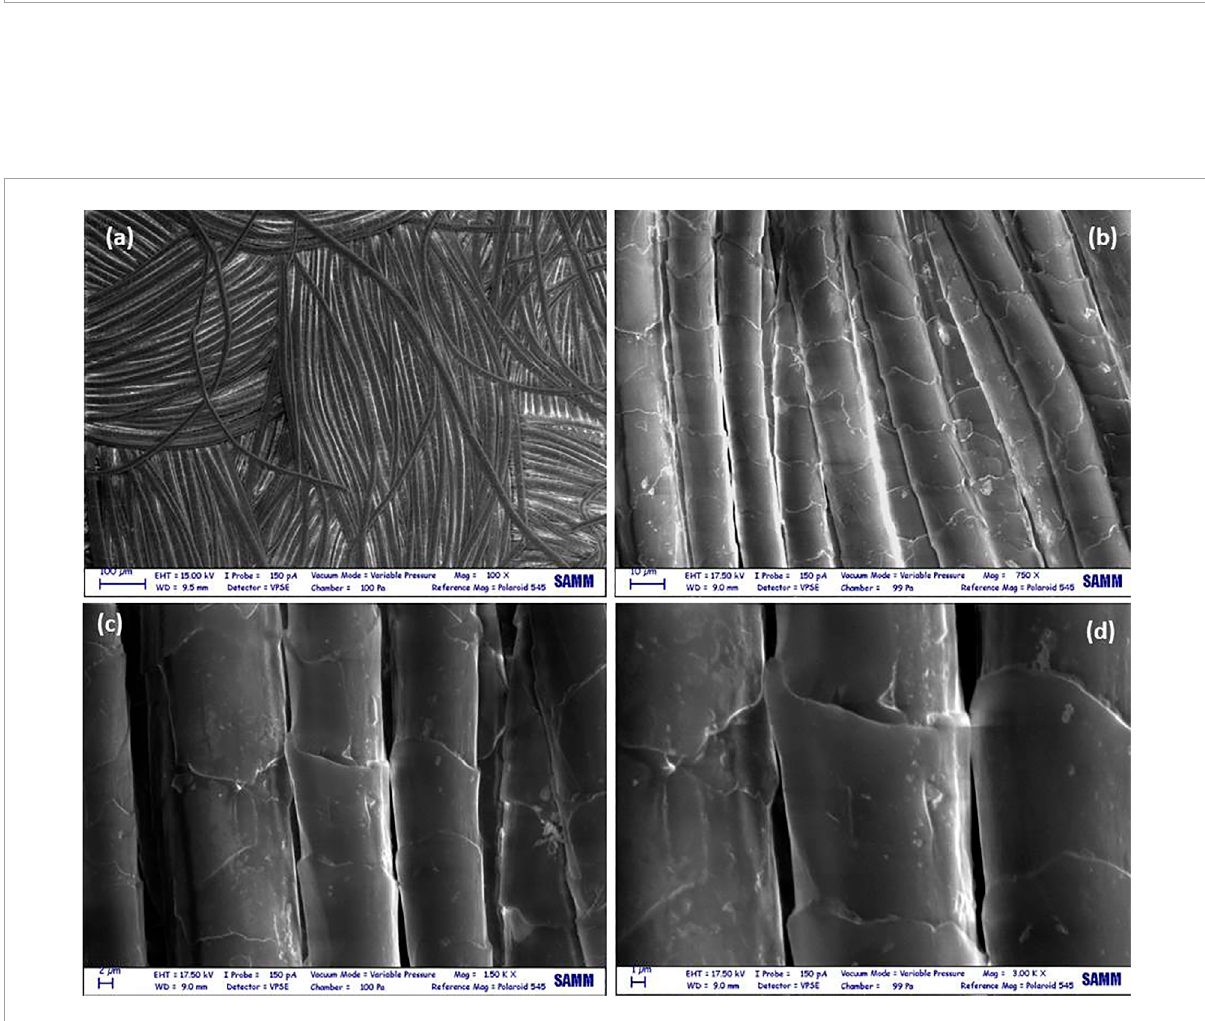
Frontiers in Materials